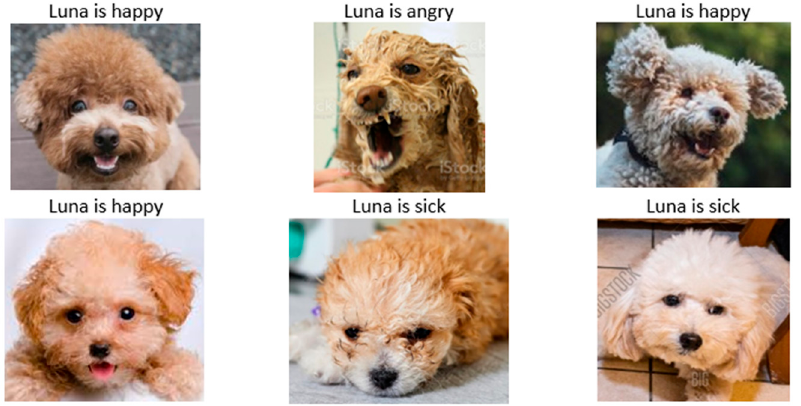
Figure 17. Prediction results of the emotions of a dog named Luna through the constructed ResNet- like model. Luna’s emotion is predicted correctly in all images.